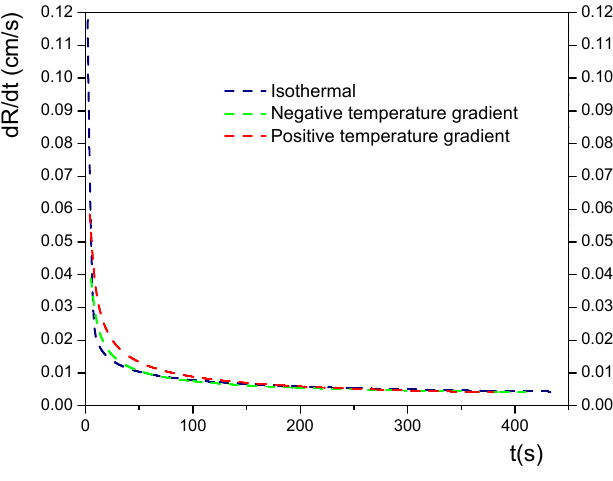
Figure 5. Plots of the averaged of velocity front as a function of time for several mean gradients. The same data as in Figure 3 were